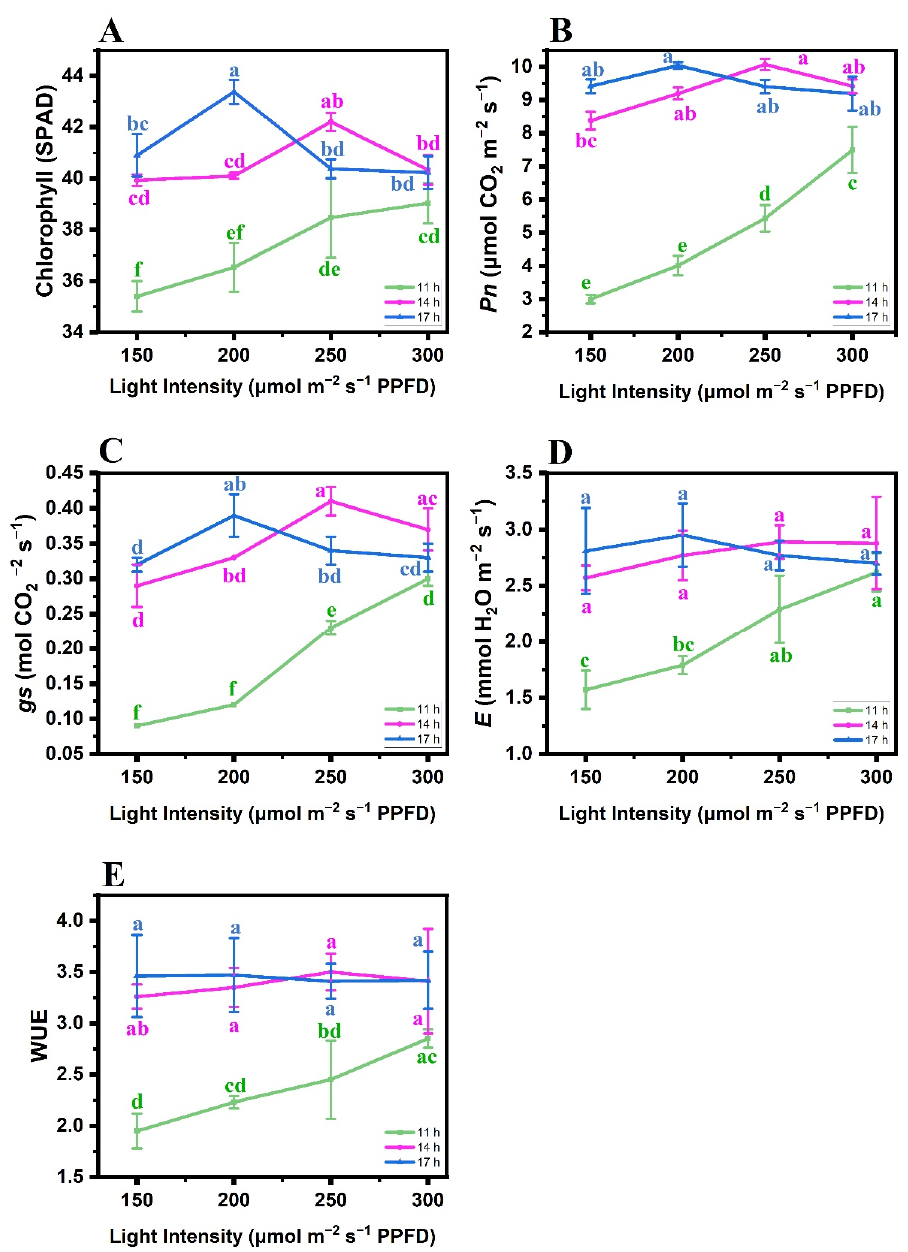
Figure 2. Effects of different photoperiod and light intensity combinations on the physiological attributes of butterhead lettuce cv. Gustav, including ( A ) chlorophyll, ( B ) rate of photosynthesis (Pn) , ( C ) stomatal conductance ( gs ), ( D ) transpiration rate ( E ), and ( E ) water use efficiency (WUE). Each data point is the mean of three independent biological replicates. The Ybar on each data point indicates the standard error within the mean. The statistical analysis is based on a twofactorial completely randomized design. The comparison of treatment means was performed by the least significance difference (LSD) test for the photoperiod and light intensity. Different letters within each graph indicate significant mean differences, as compared by the LSD ( p ≤ 0.05).